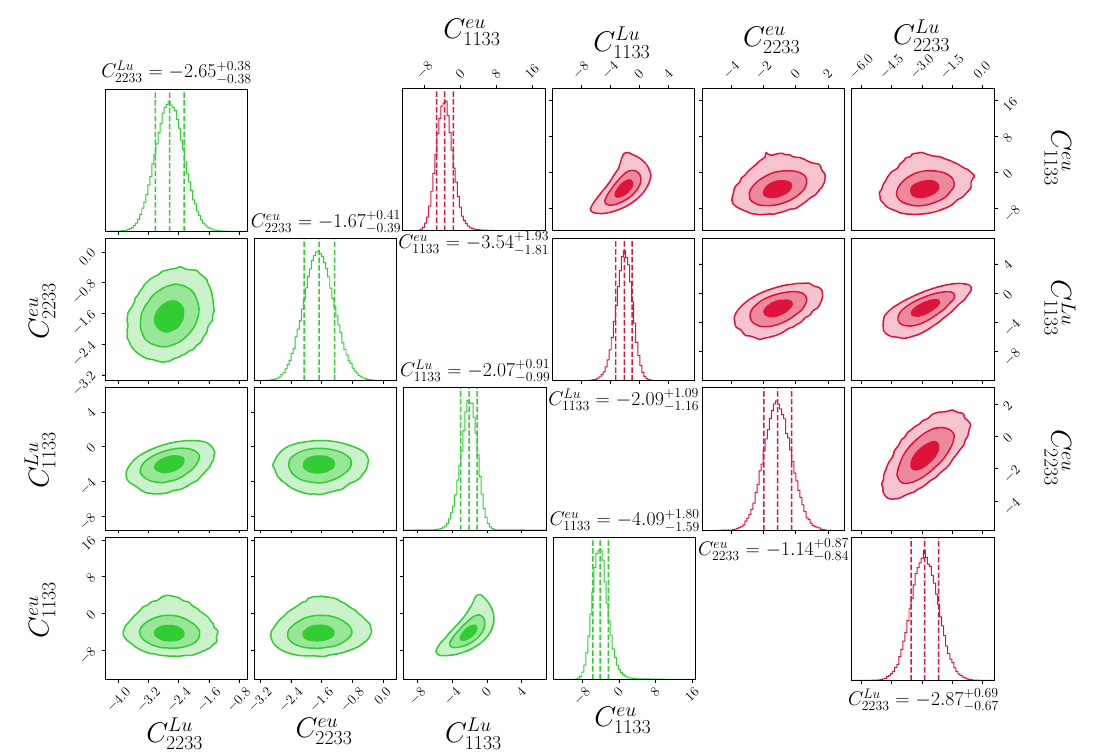
Fig. 10 Global fit of RGE-induced contributions ( Λ = 1 TeV ) from Eq. (17) constrained by b → s (cid:2) + (cid:2) − data within the PMD (green) and PDD (red) approach, including the new R K measurement. 16-th, 50-th, 84-th percentile for marginalized distributions is shown